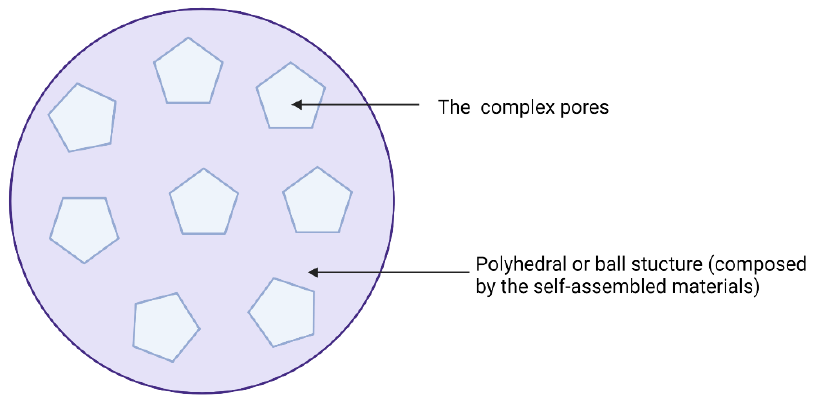
Figure 10. Schematic of immune-stimulating complexes (ISCOMs) Pre-Clinical and Clinical Development of Saponin and Its Derivatives